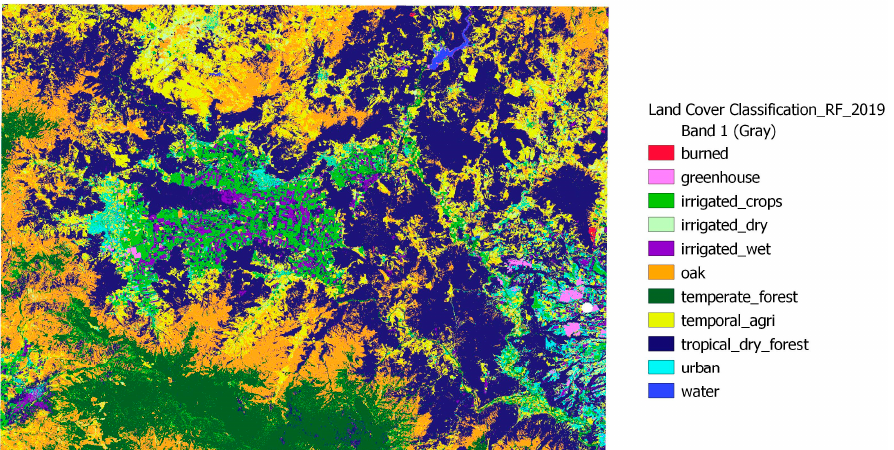
Figure A4. Land cover classification using random forest (RF) for 2019. Irrigated crops is short for Irrigated agriculture with crops; Irrigated dry is short for Irrigated agriculture without crops (dry); Irrigated wet is short for Irrigated agriculture without crops (wet); Temporal agriculture is short for Temporal agriculture with pasture; Oak is short for Oak forest.